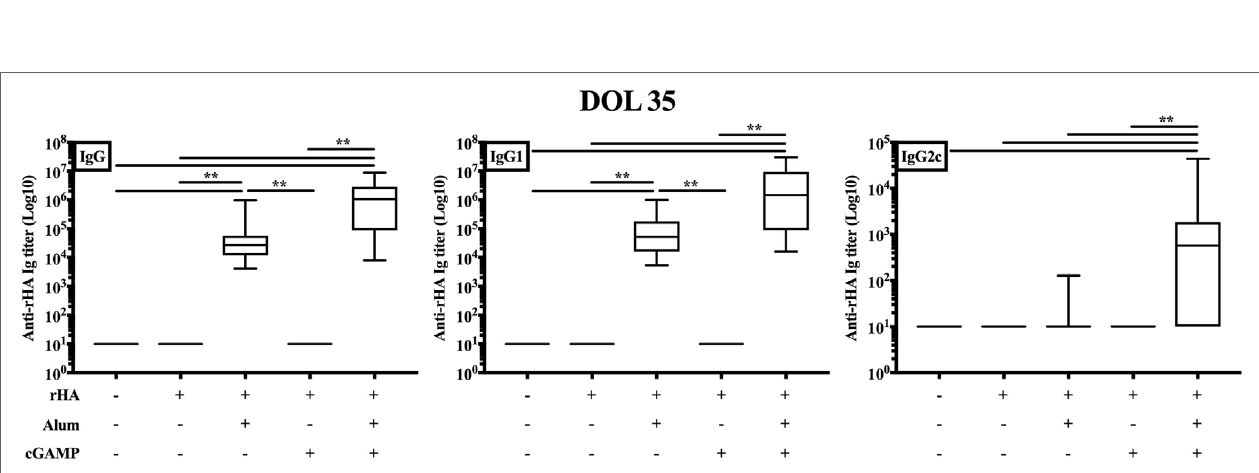
FigUre 6 | Immunization with (cGAMP + alum) does not modulate recombinant hemagglutinin (rHA)-specific IgG avidity. Newborn mice were immunized with rHA formulated with alum or (cGAMP + alum) and serum samples were collected as indicated in Figure 2 . Avidity of rHA-specific IgG was measured by ELISA and expressed as the ratio between the LogEC50 values obtained with and without ammonium thiocyanate treatment (0.5 M). Results are shown as median (left panel) or as the median, the 25th and 75th percentiles (boxes) and the 5th and 95th percentiles (whiskers) (right panels) of 7–8 newborn mice per group. * p < 0.05, ** p < 0.01 determined by two-way ANOVA with Sidak’s post hoc test (left panel) or Mann-Whitney test (right